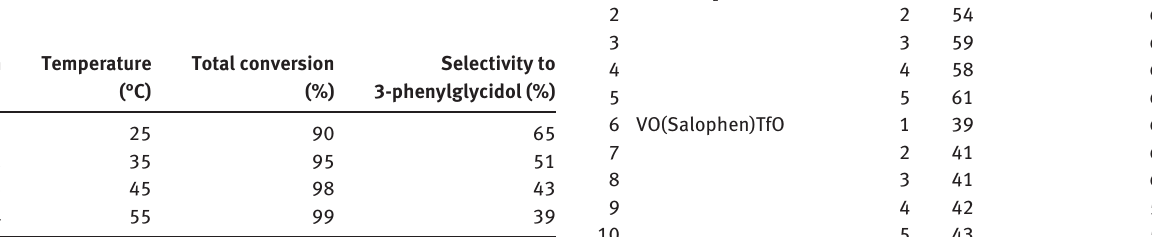
, 1.5 equiv. TBHP, 2 h, in [bmim] 2